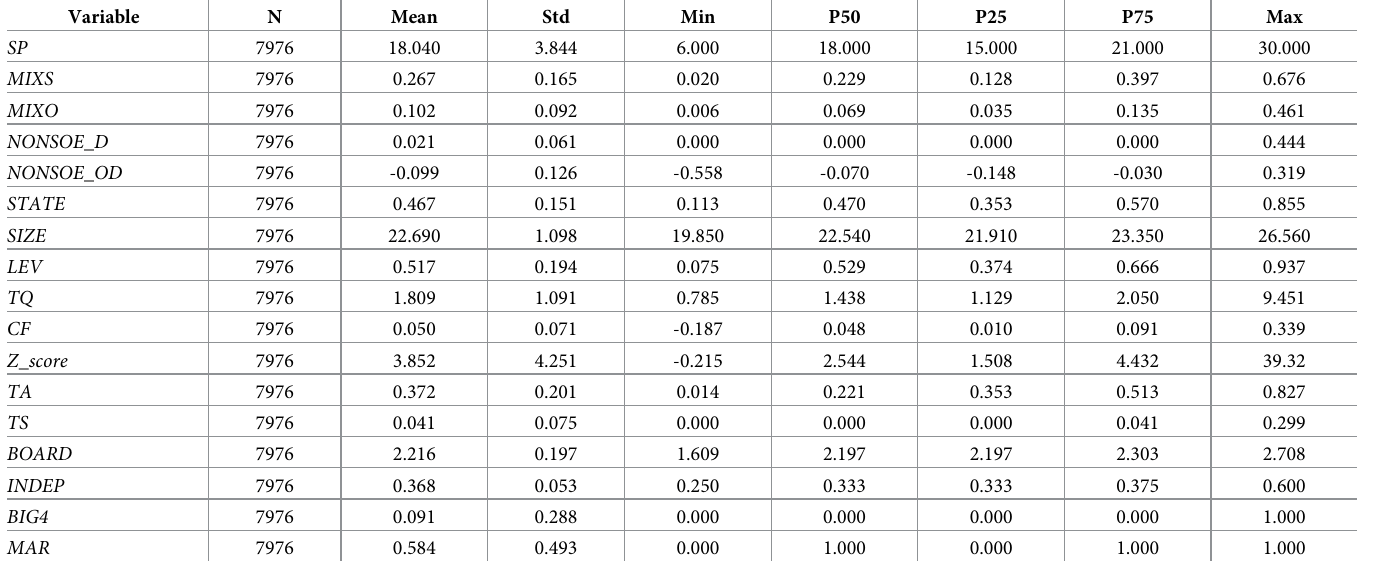
Table 2. Descriptive statistics of the main